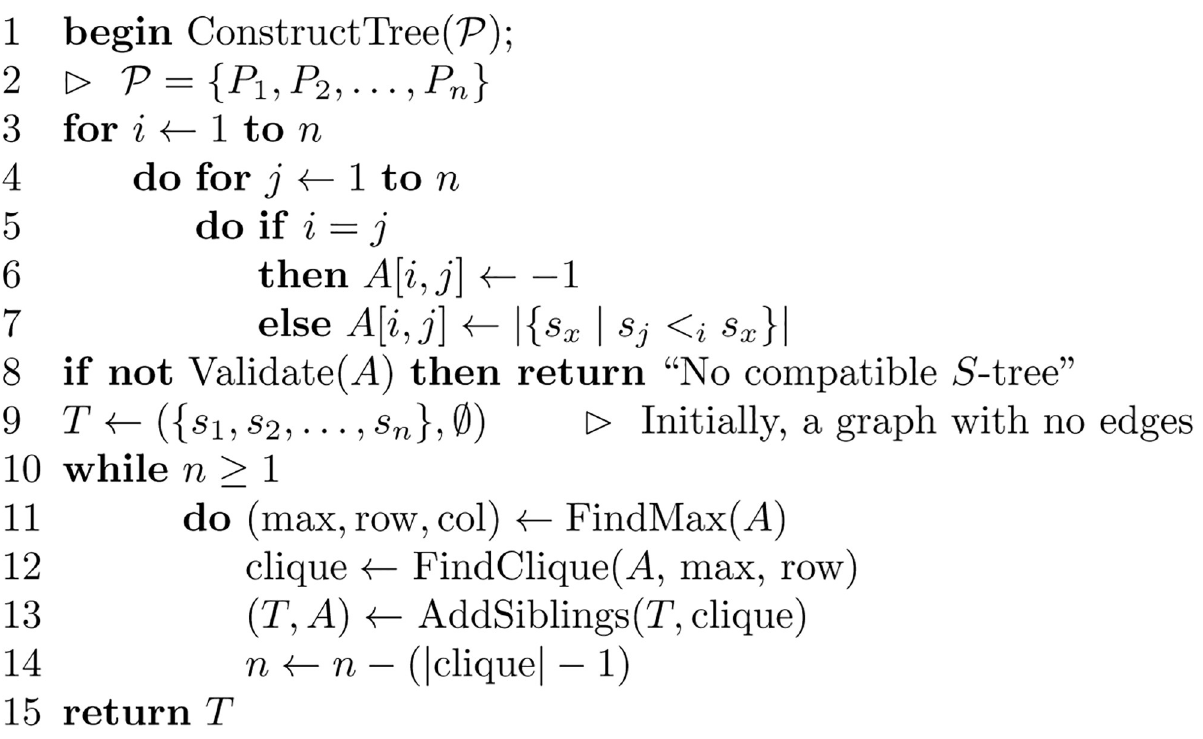
Fig 17. Algorithm to construct an S -tree from a set of posets P ¼ f P